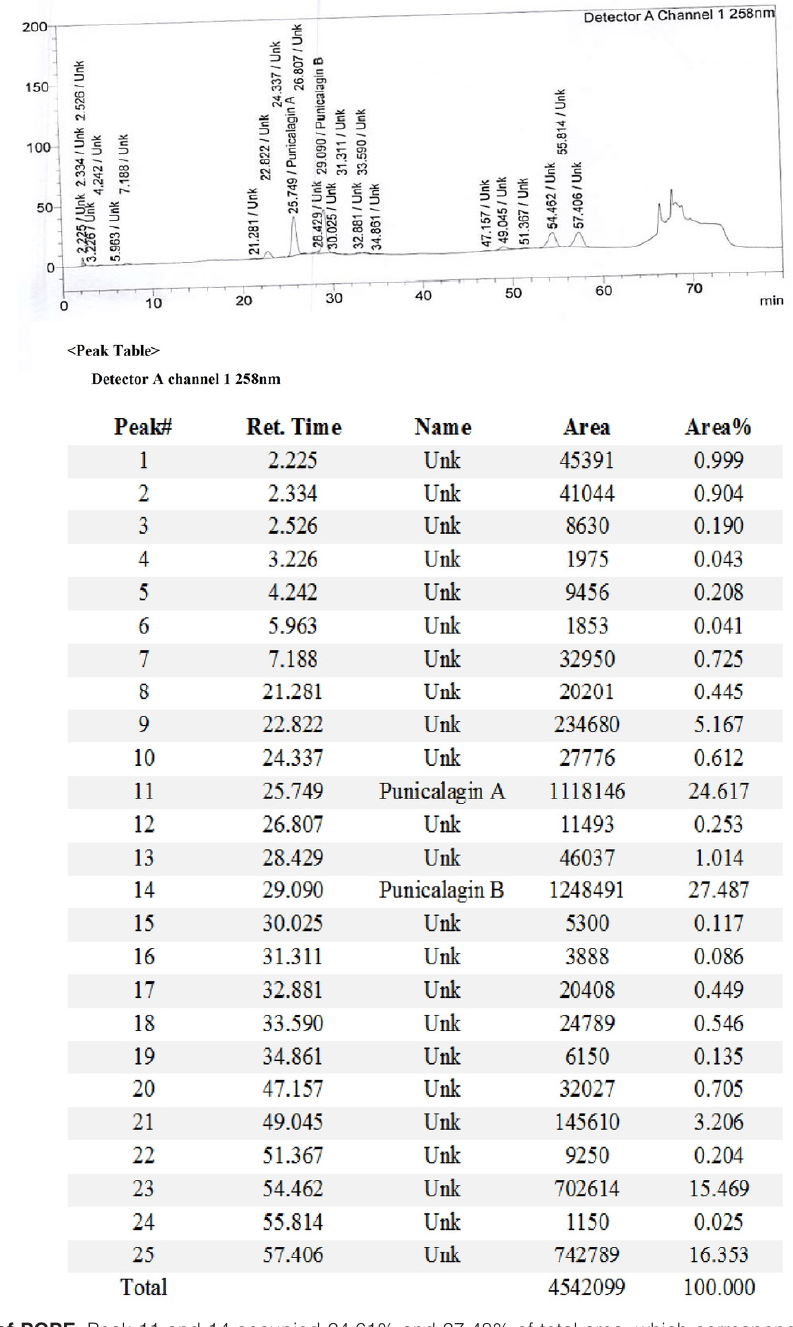
Figure 4. HPLC profile of PGPE. Peak 11 and 14 occupied 24.61% and 27.48% of total area, which corresponds to Punicalagin A and B, respectively. PGPE, Punica granatum peel